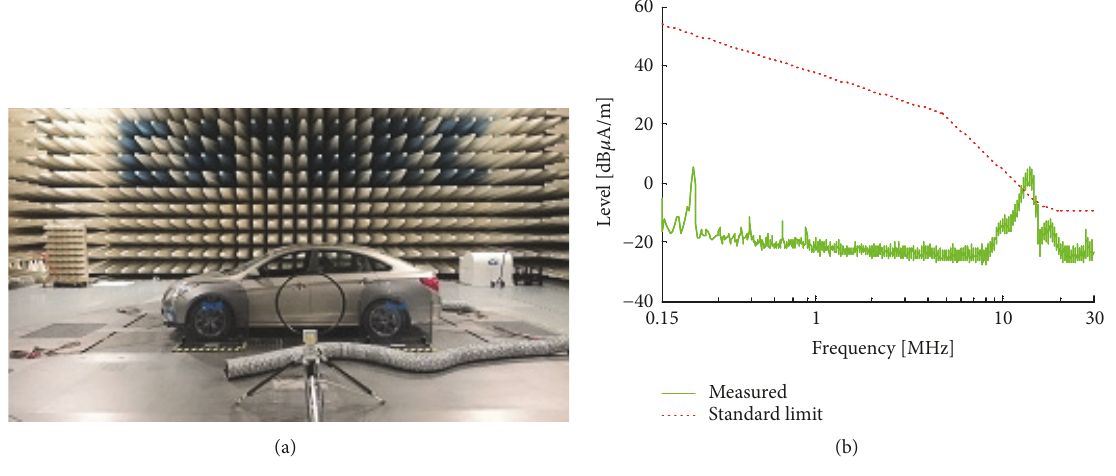
Figure 1: Experimental test of J551-5: (a) test setup; (b) test results.